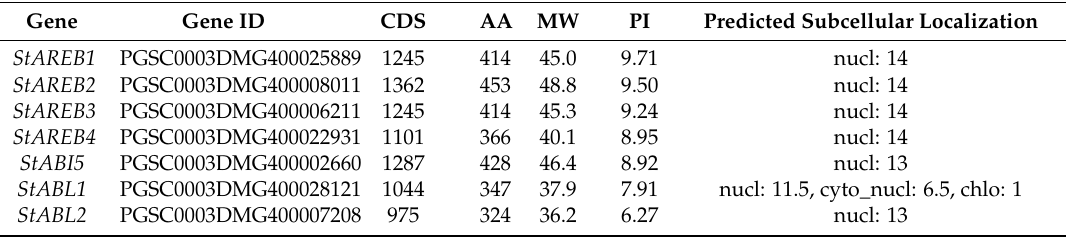
Table 1. General information for potato AREB/ABF/ABI5 genes.